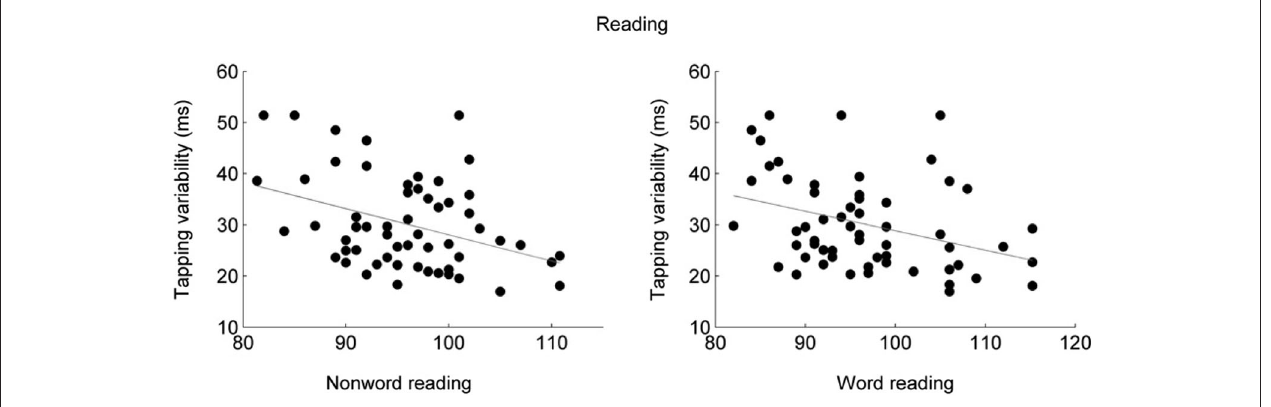
performance was measured as the average standard deviation across two speeds, 1.5 and 2 Hz. Word and nonword reading abilities were assessed using the Test of Word Reading Efficiency (TOWRE; Torgeson et al.,